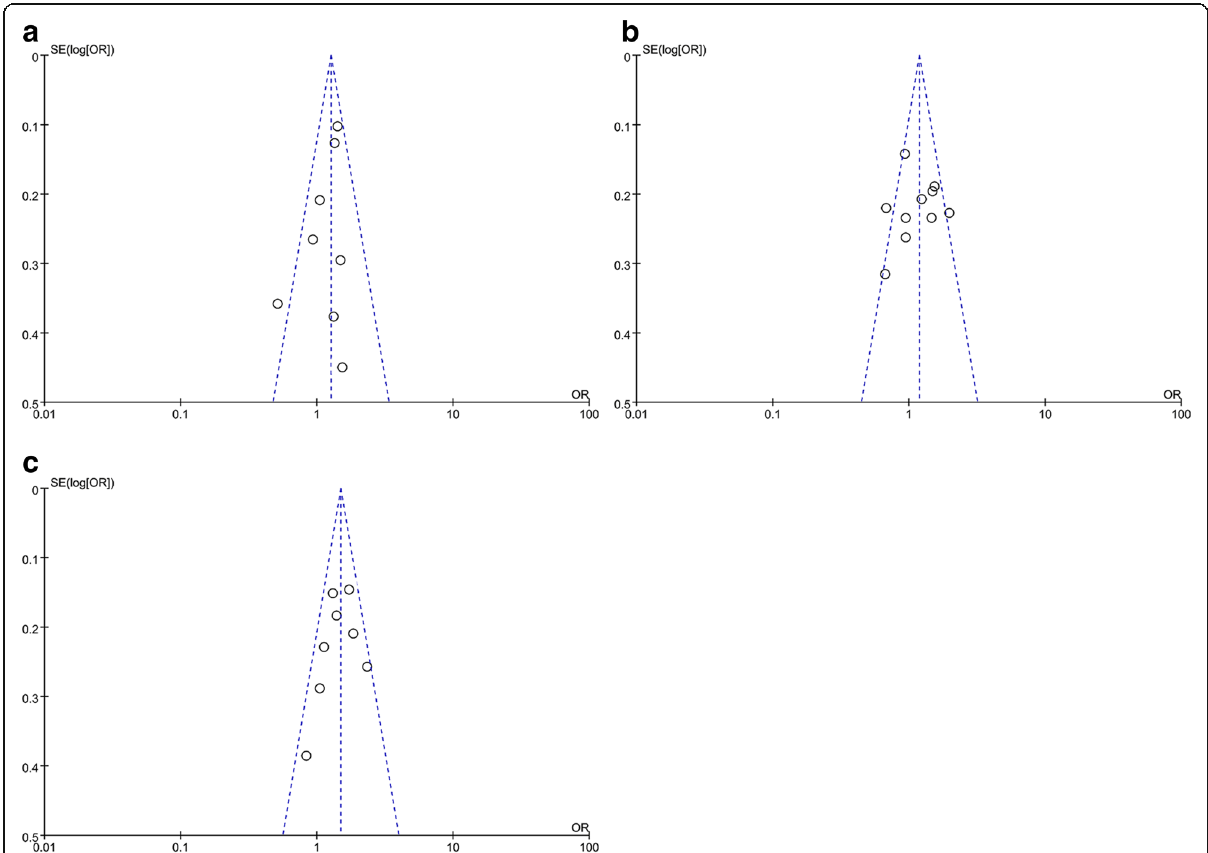
Fig. 3 Funnel plot for studies investigating the effect of VEGF gene polymorphisms on CAD risk. a Funnel plot for publication bias on the rs699947 polymorphism; b Funnel plot for publication bias on the rs2010963 polymorphism; c Funnel plot for publication bias on the rs3025039 polymorphism. Abbreviation: OR = odds